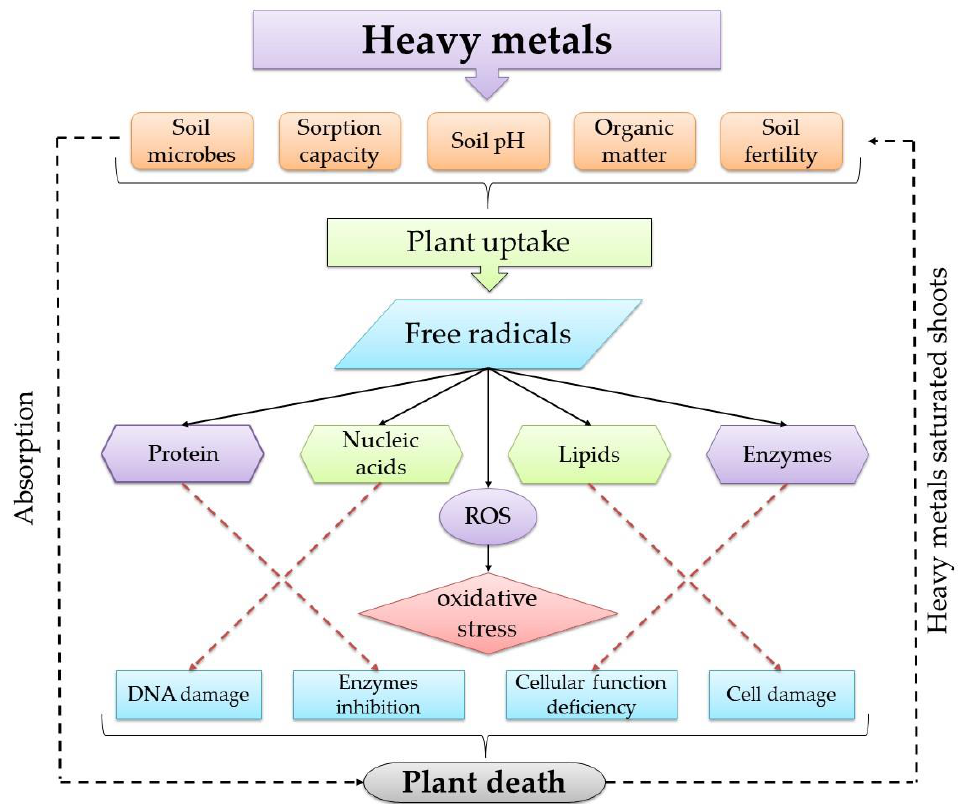
Figure 6. Mechanism of action and pathway of heavy metals toxicity in soil and plant.